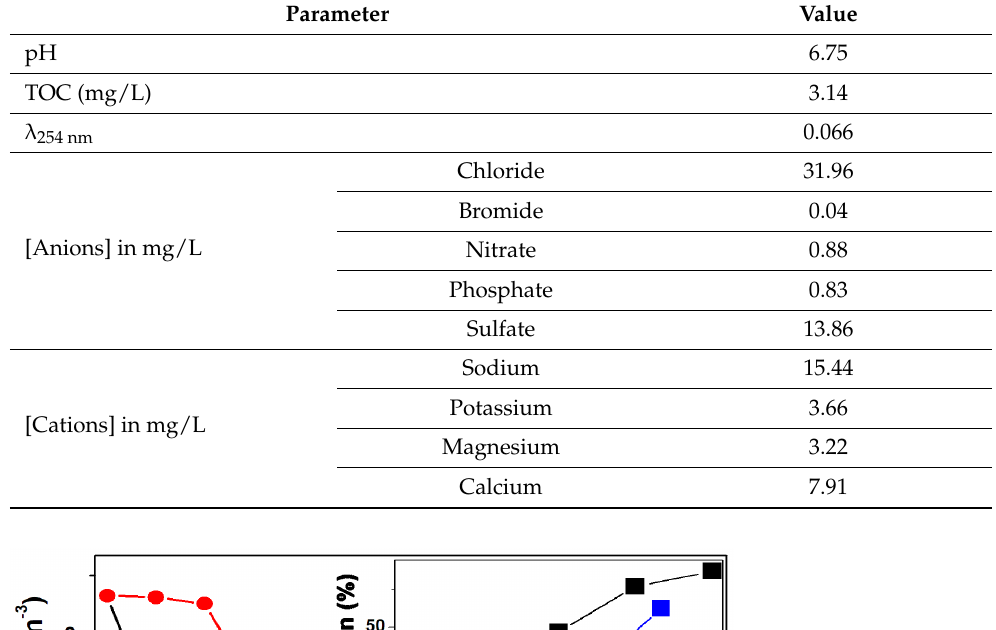
Table 1. Characteristics of river water.